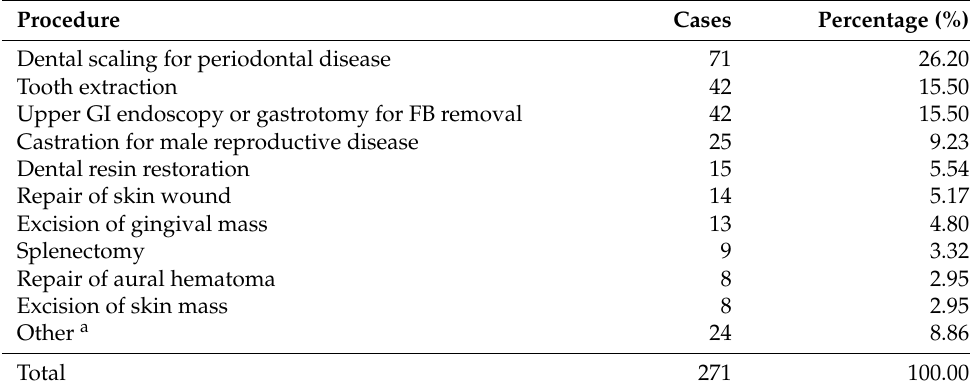
Table 7. The common surgical procedures.